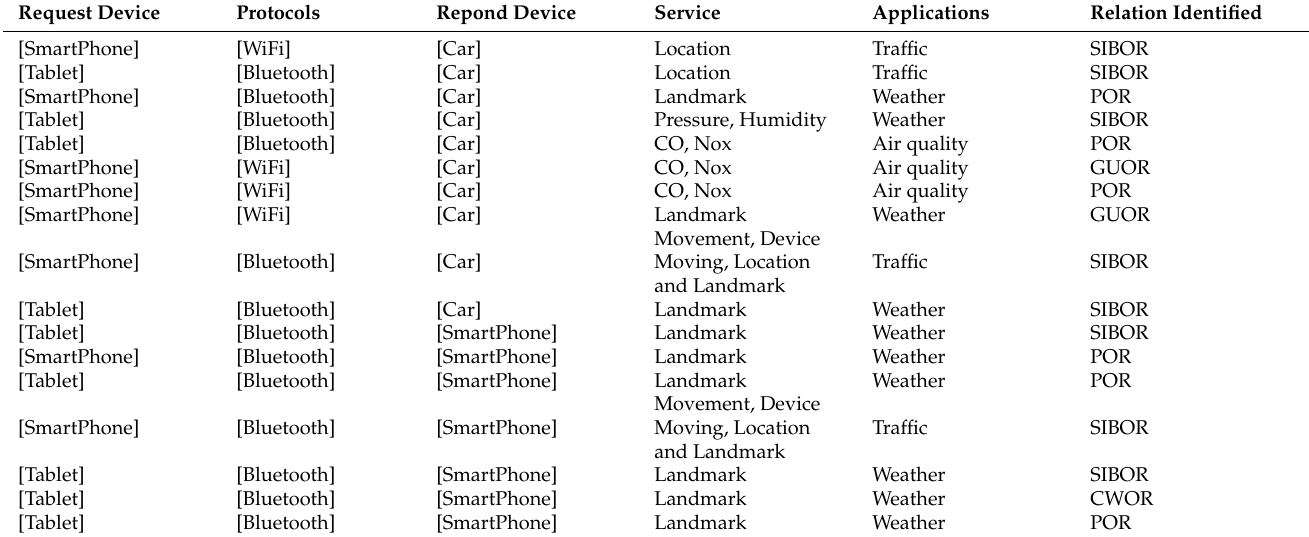
Table 9. Requestdevices and Responddevices .